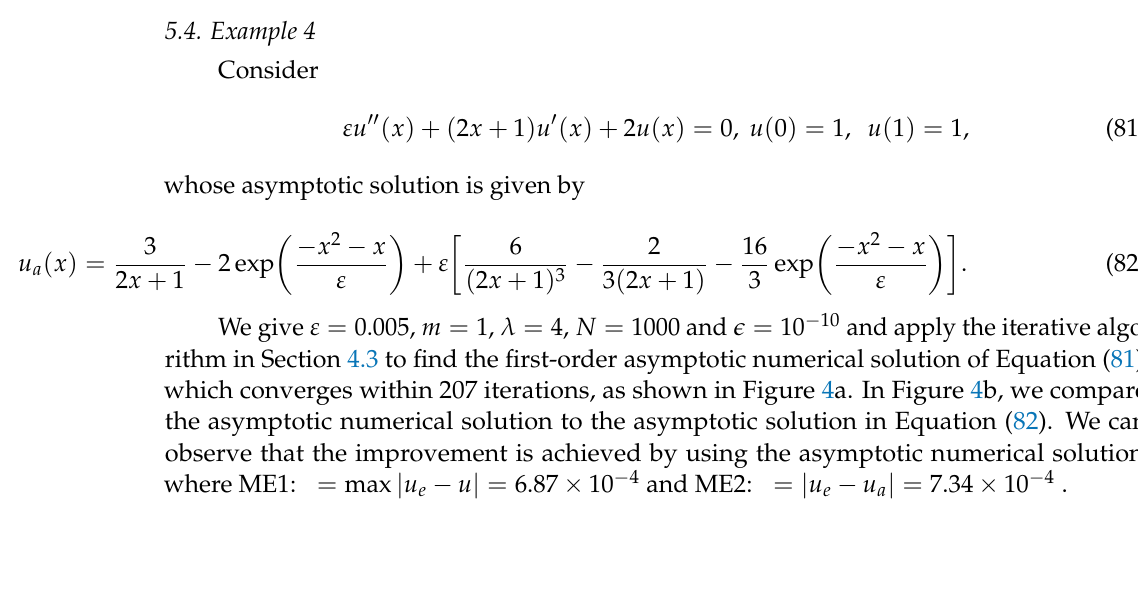
Figure 3. For example 3: ( a ) showing the convergence of iterations; and ( b ) comparing the exact solution, a uniform approximation and the present first-order